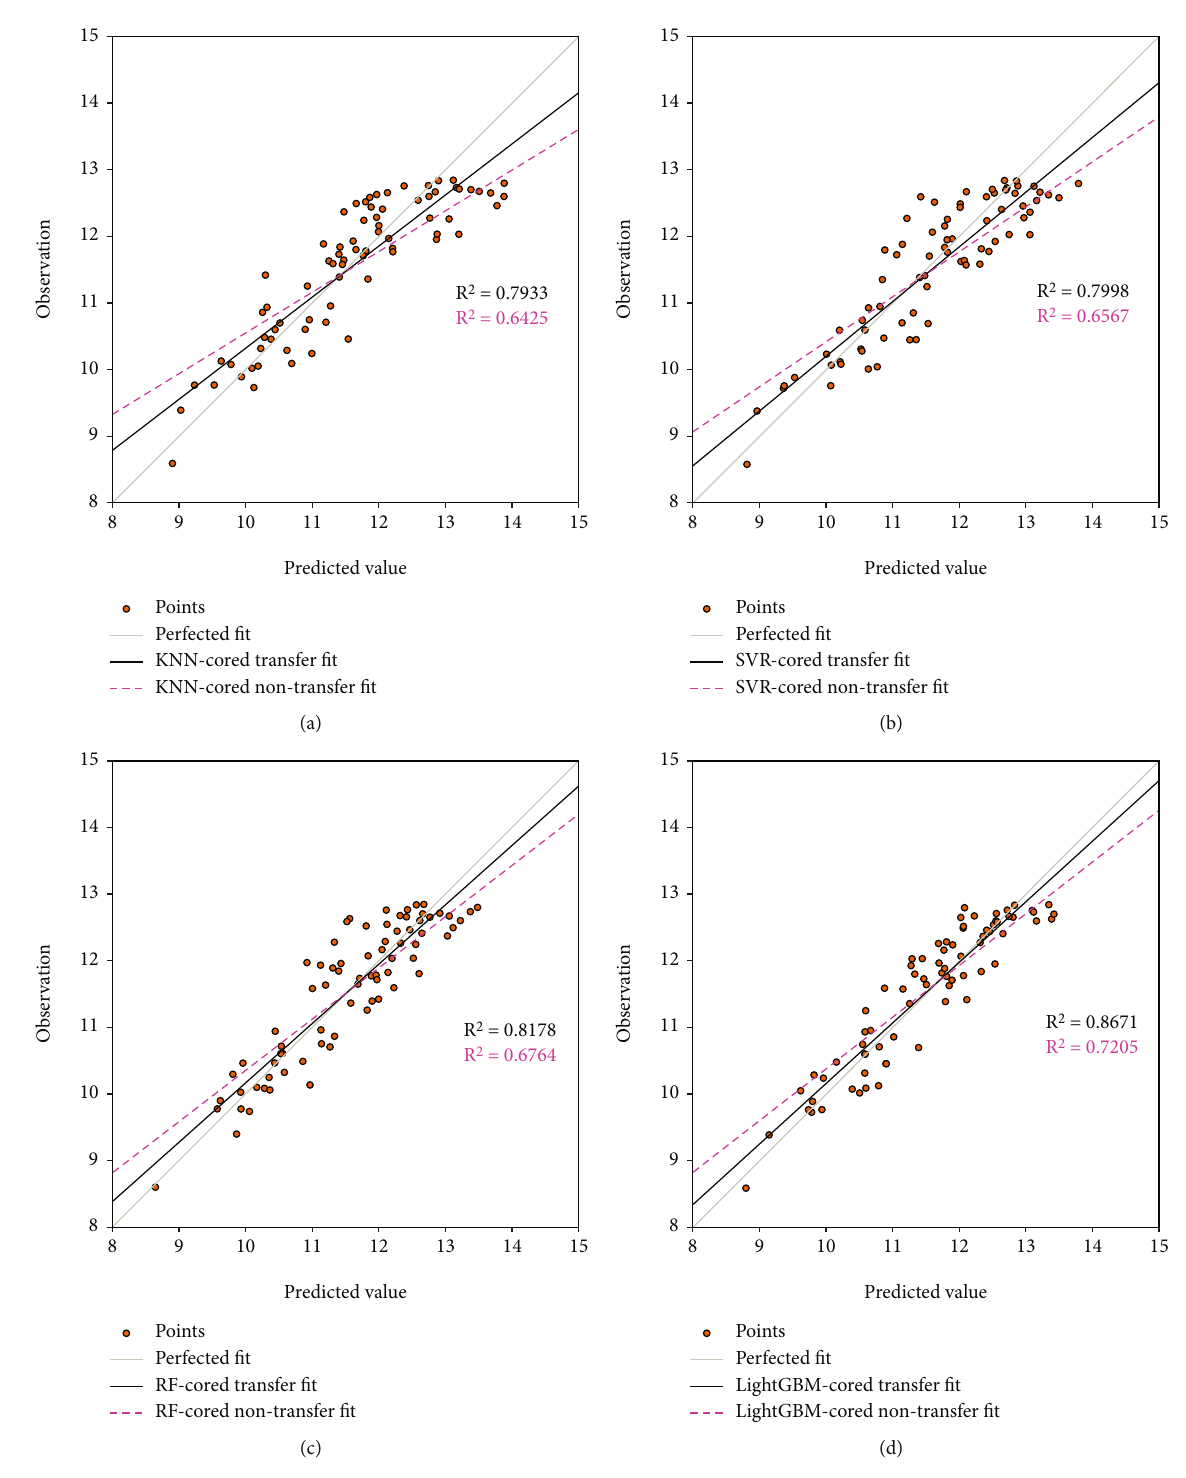
Figure 15: Fitness of porosity results provided by KNN-cored predictor (a), SVR-cored predictor (b), RF-cored predictor (c), and LightGBM-cored predictor (d) in the third experiment. KNN =k-nearest neighbors; SVR =support vector regression; RF=random forest; LightGBM=light gradient boosting machine; RMSE =root-mean-square